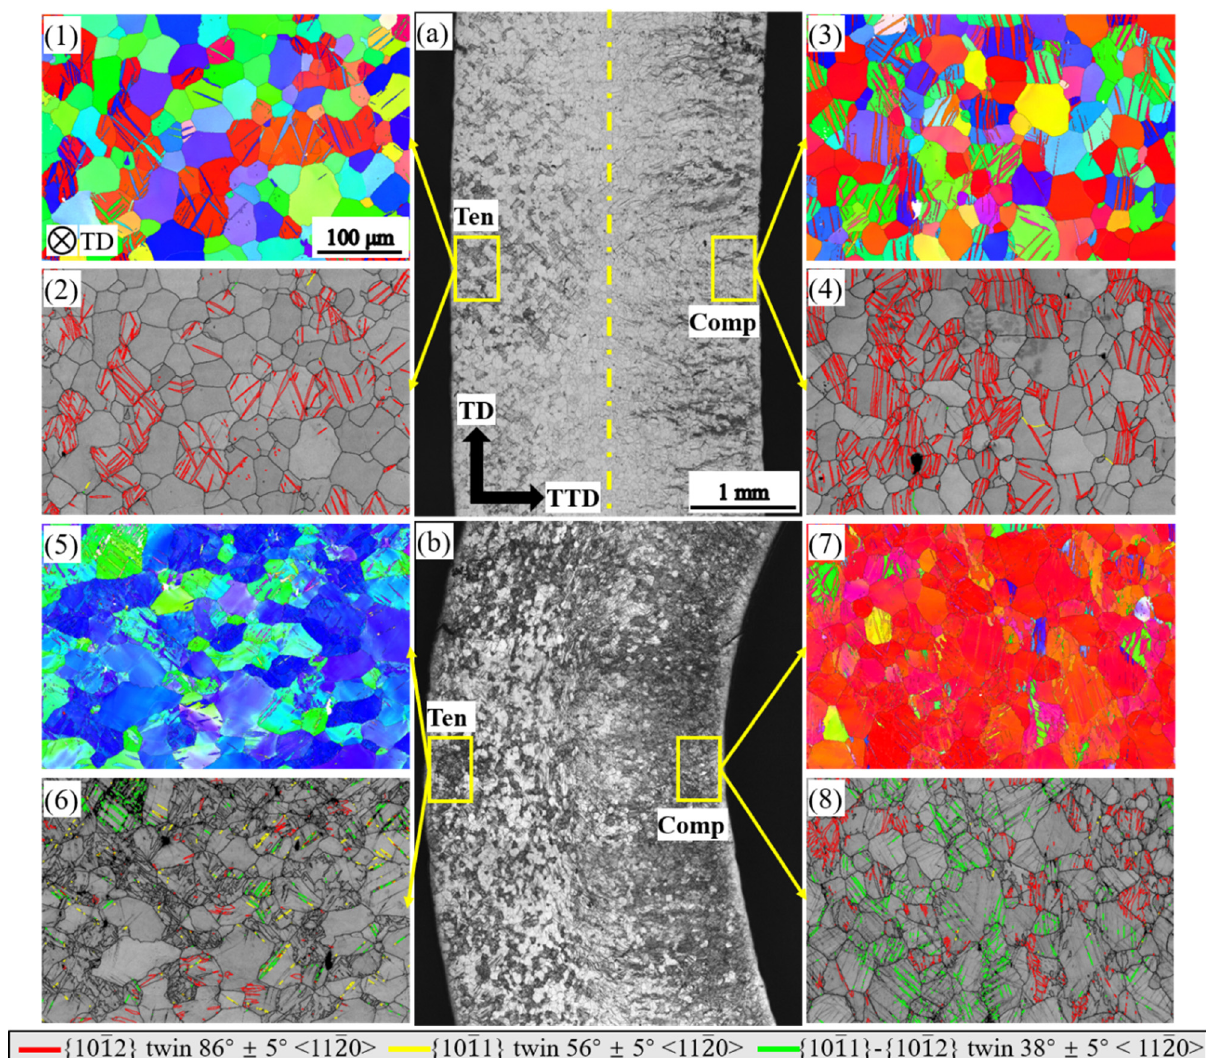
Figure 5. Microstructure of the TD bending bar at a bending displacement of 3 mm and at fracture: ( a , b ) optical micrograph of the bent sample; ( 1 , 3 , 5 , 7 ) inverse pole figures of the bent bar; ( 2 , 4 , 6 , 8 ) band contrast map of the bent bar with twinning boundary characterized.